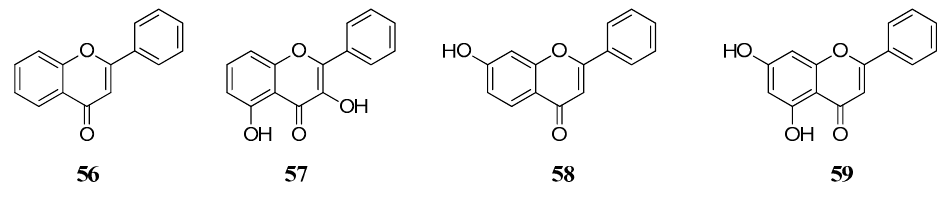
Figure 12. Structures of compounds 56 – 59 .